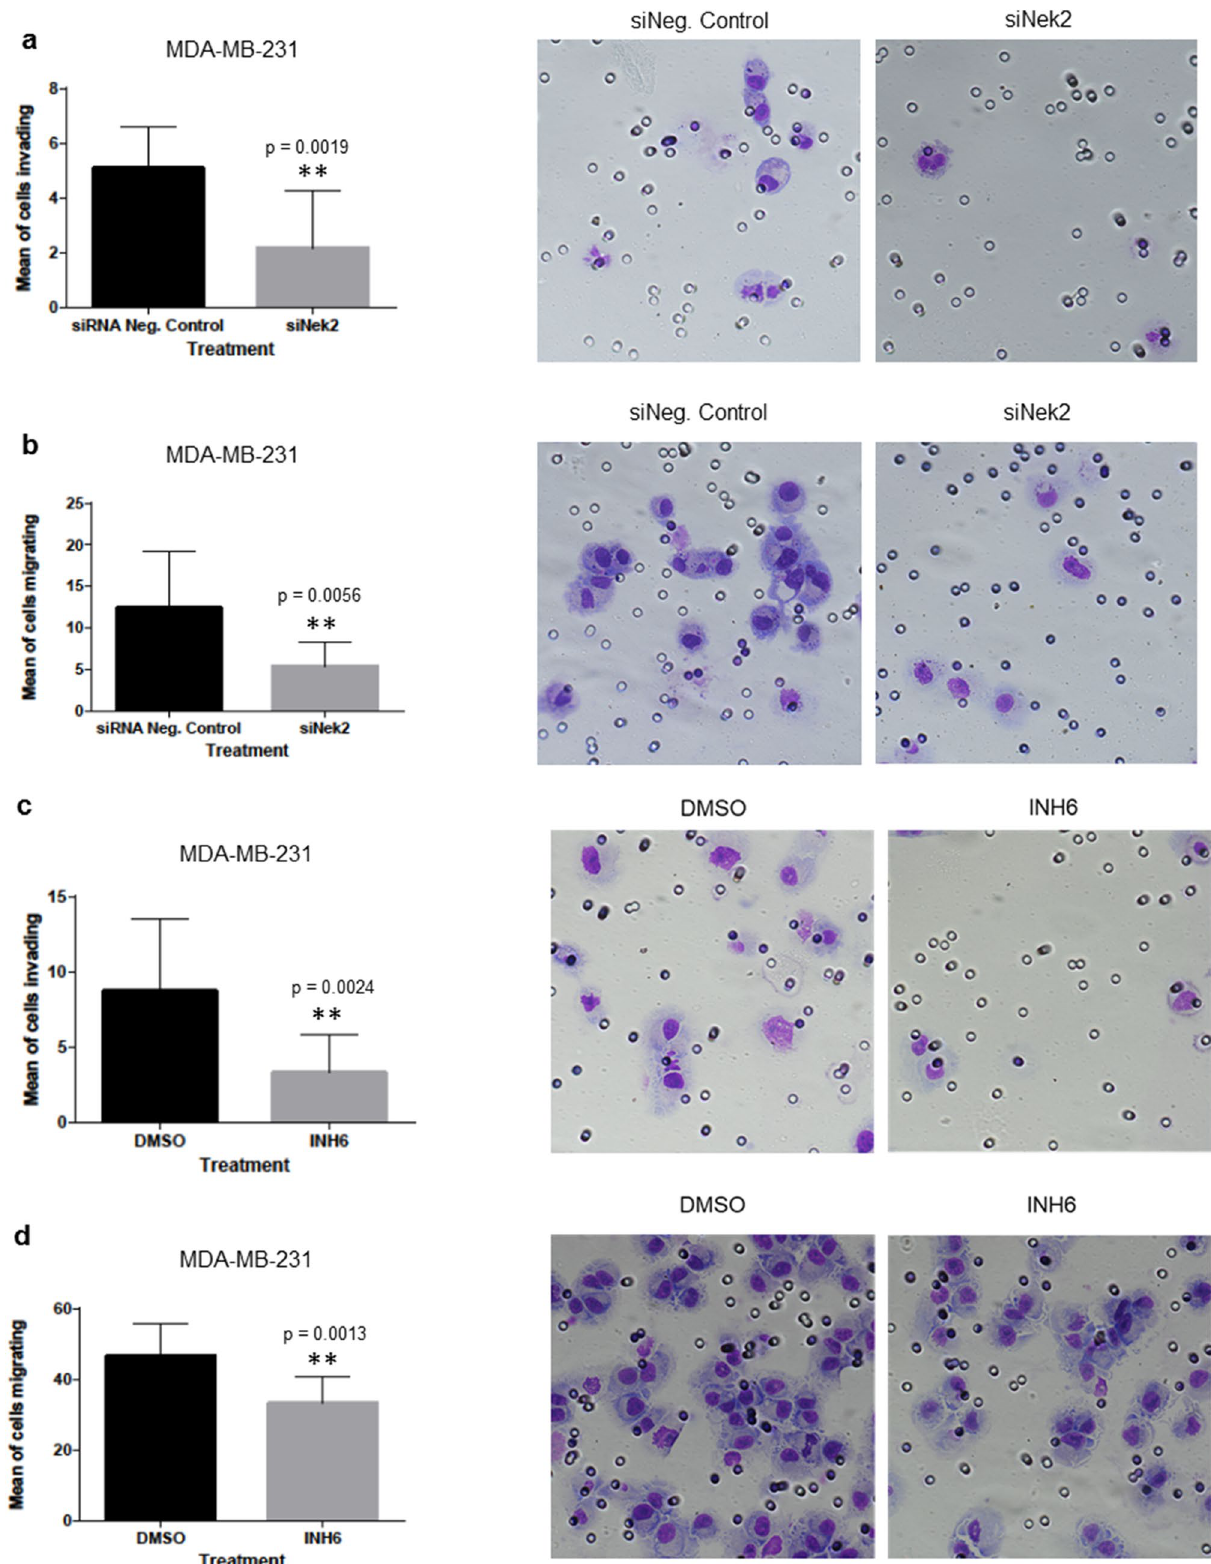
Figure 5. Nek2 is required for invasion and migration in triple-negative breast cancer cells. ( a–d ) Invasion and migration of MDA-MB-231 cells treated with siNek2 ( a ) and ( b ) or INH6 (c) and ( d ). ( e–f ) Invasion and migration of Hs578t treated with siNek2. ( g,h ) CCK8 cell proliferation assay was assessed in MDA-MB-231 using siNek2 ( g ) or INH6 ( h ). Data represent mean fold change ± SEM of three independent